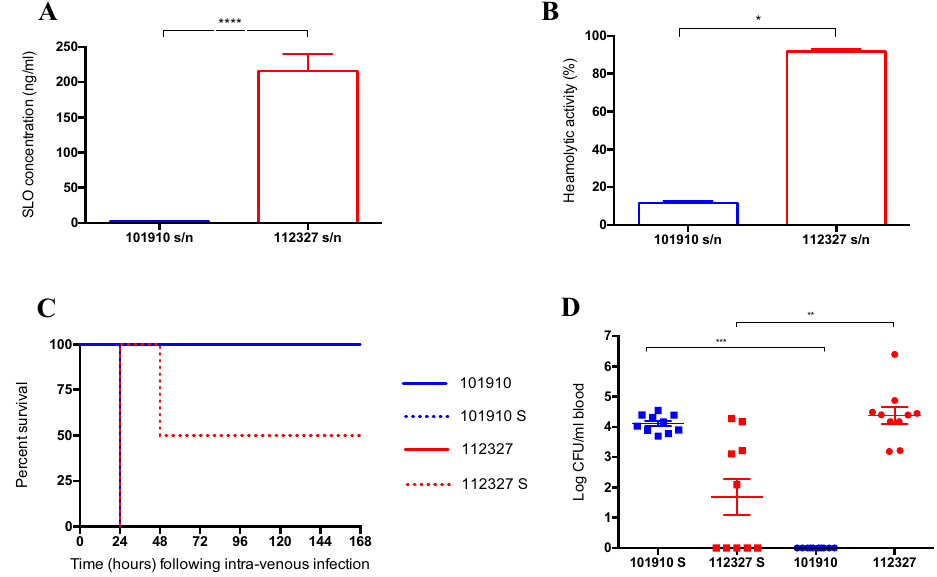
Figure 5. Effect of concentration and activity of secreted SLO on virulence in vivo. ( A ) Concentration of streptolysin (ng/ml) and ( B ) haemolytic activity in infection doses of emm type 1.0 (isolate 101,910) and emm type 32.2 (isolate 112,327), when prepared in 1 ml of PBS, incubated at room temperature for 30 min. ( C ) Kaplan Meier survival plots representing survival of CD1 mice (n = 10 per group) when intravenously infected (10 8 CFU) with isolates 101,910 and 112,327, and 112,327 bacteria re-suspended in supernatant from 101,910 challenge dose (112,327 S) or 101,910 bacteria re-suspended in supernatant from 112,327 challenge dose (101,910 S). ( D ) Bacterial burden in blood 24 h after infection with isolates 101,910 and 112,327 and swapped supernatant isolates as above. **p value < 0.01, ***p < 0.005 and ****p value < 0.001 when analysed using a one- way ANOVA followed by a Kruskall-Wallis multiple comparisons test.